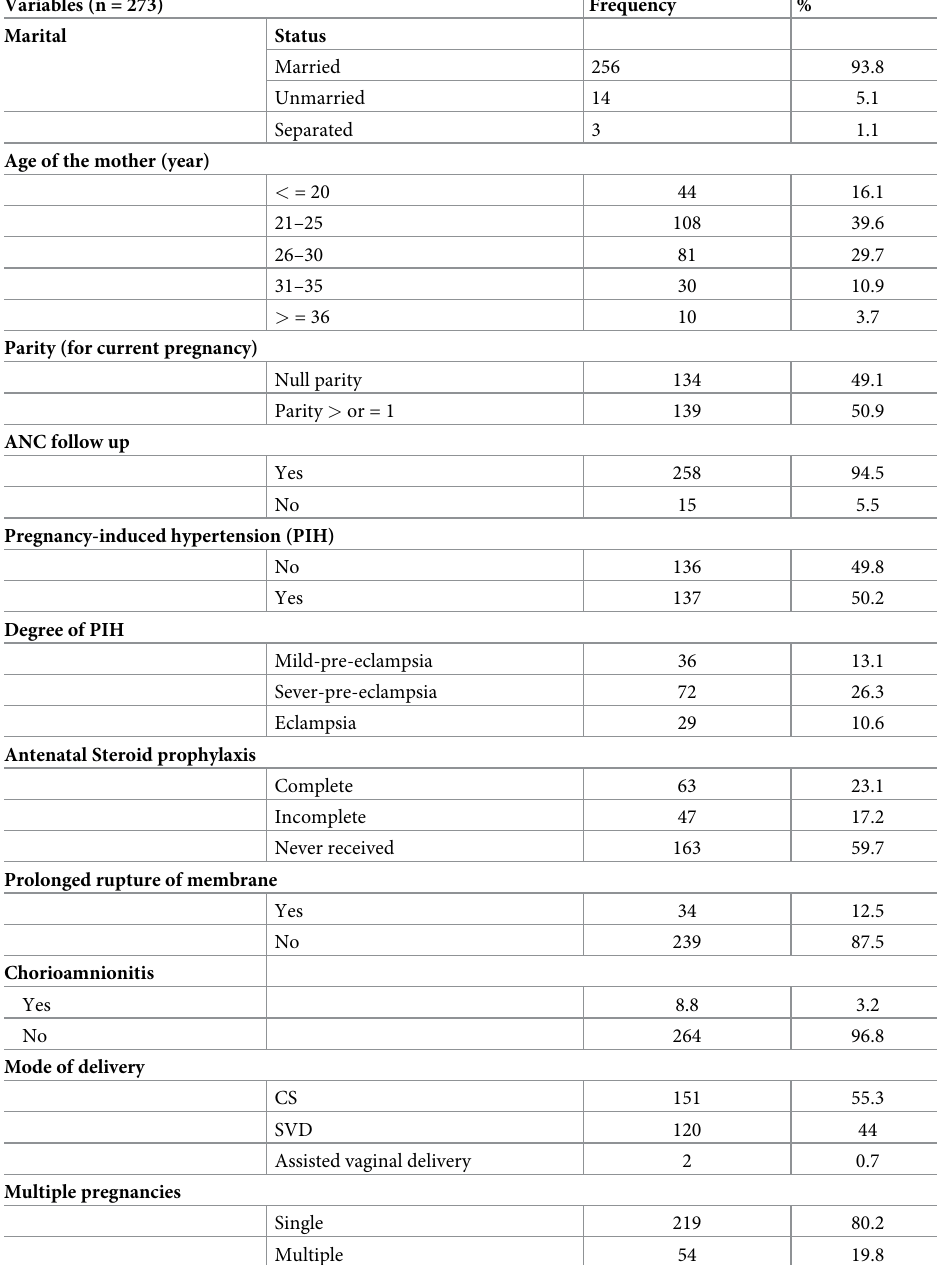
Table 1. Maternal demographic and obstetric characteristics of LBW neonates admitted to the neonatal ICU in Hawassa city, Sidama region, Ethiopia, 2019. Variables (n = 273)